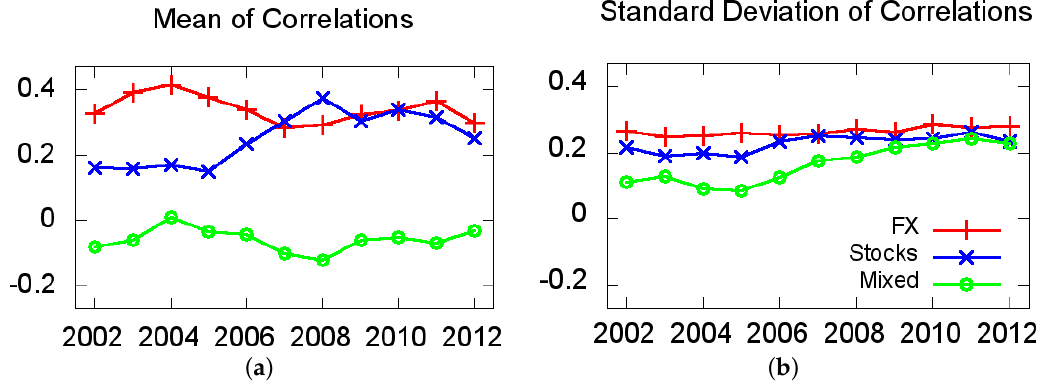
Figure 2. ( a ) Annual mean correlation and ( b ) annual standard deviation for stock markets (x), foreign exchange markets (+), and between stock and foreign exchange markets (o). We observe that the stock markets are more correlated during the crisis period, whereas the foreign exchange market correlation are higher in the non-crisis period. The correlation between stock and foreign exchange markets is lowest during the crisis. The standard deviation for both, stock and foreign exchange markets remains fairly constant, while we observe an increase in the standard deviation for the interlayer correlations.